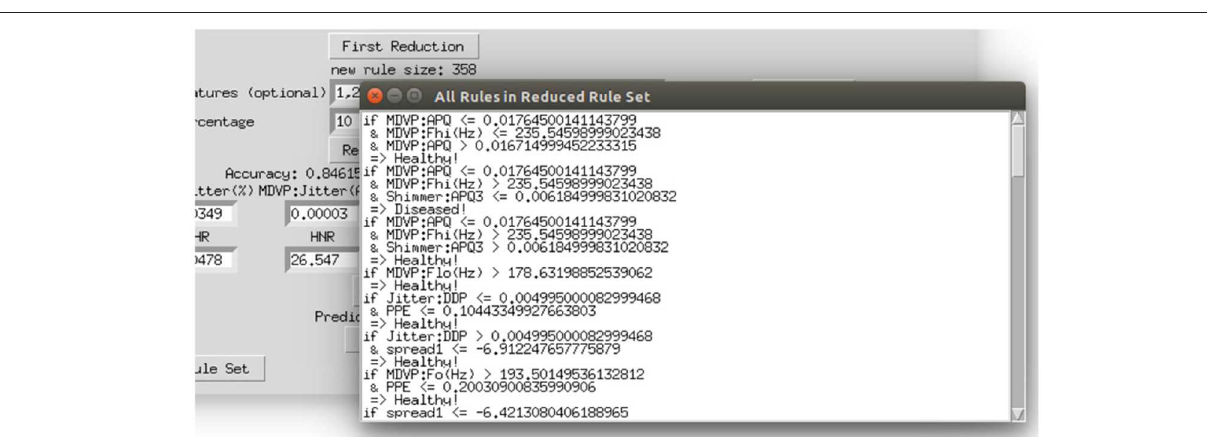
FIGURE 9 | Displaying all rules that remained in the reduced rule set.